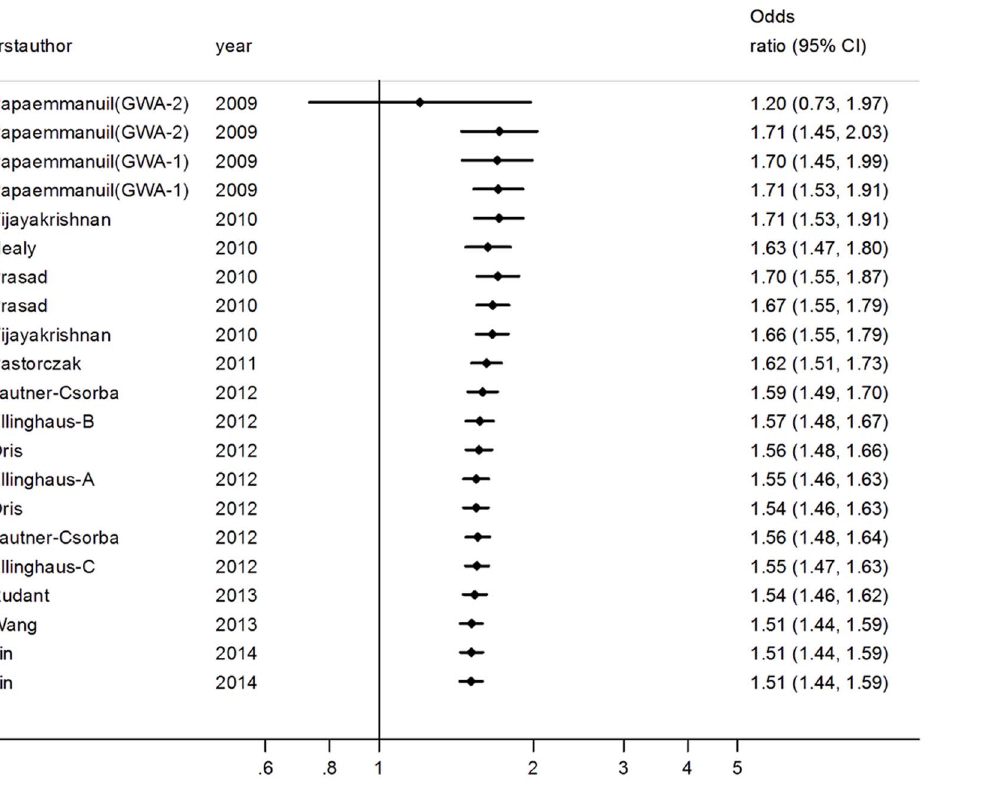
Figure 4. Cumulative meta-analysis: pooled OR with the corresponding 95% CI at the end of each year information step is shown for IKZF1 rs4132601 polymorphism in allelic contrast model (G vs T). CI: confidence interval; OR: Odds